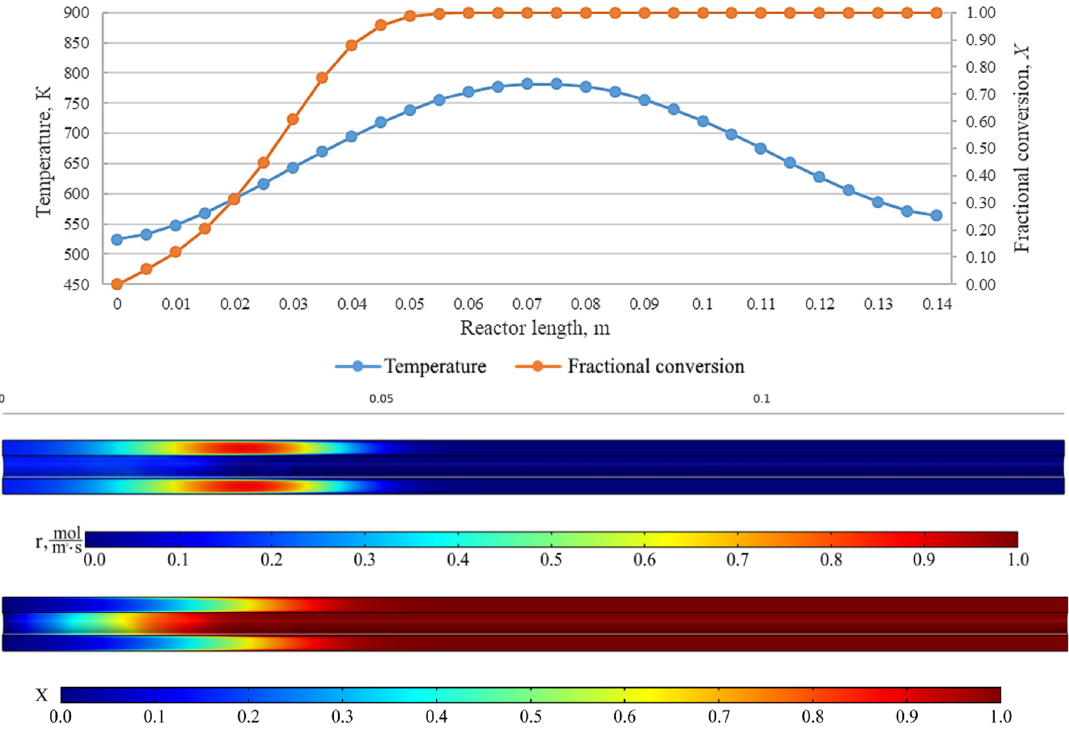
Figure 9. From top to bottom: temperature and fractional conversion curves, profiles of the reaction rate and fractional conversion along the reactor length for the experiment BnOm_350_40 (Tmax = 350 ◦ C, V = 0.25 L / min).